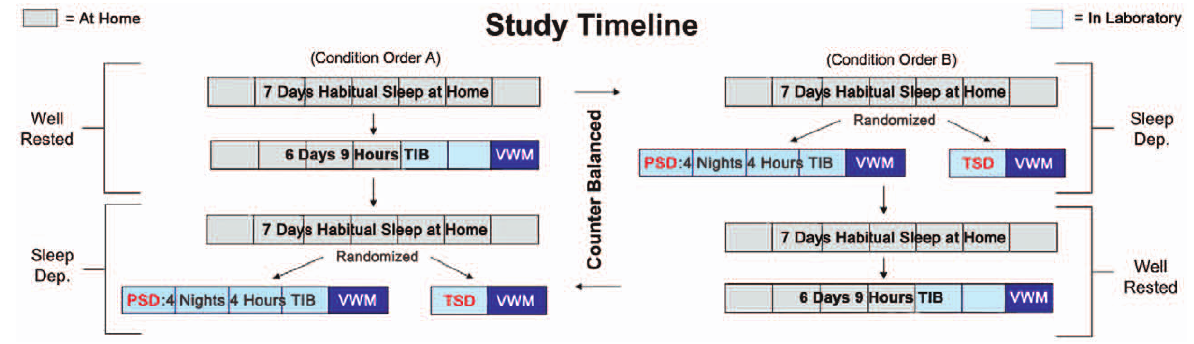
Figure 1. Protocol Timeline. There were two possible orders for the sleep conditions: either well-rested first or sleep deprivation first (order A and order B). Participants were randomly assigned to either the PSD or TSD groups and the order of sleep conditions was counter balanced across participants within each group.